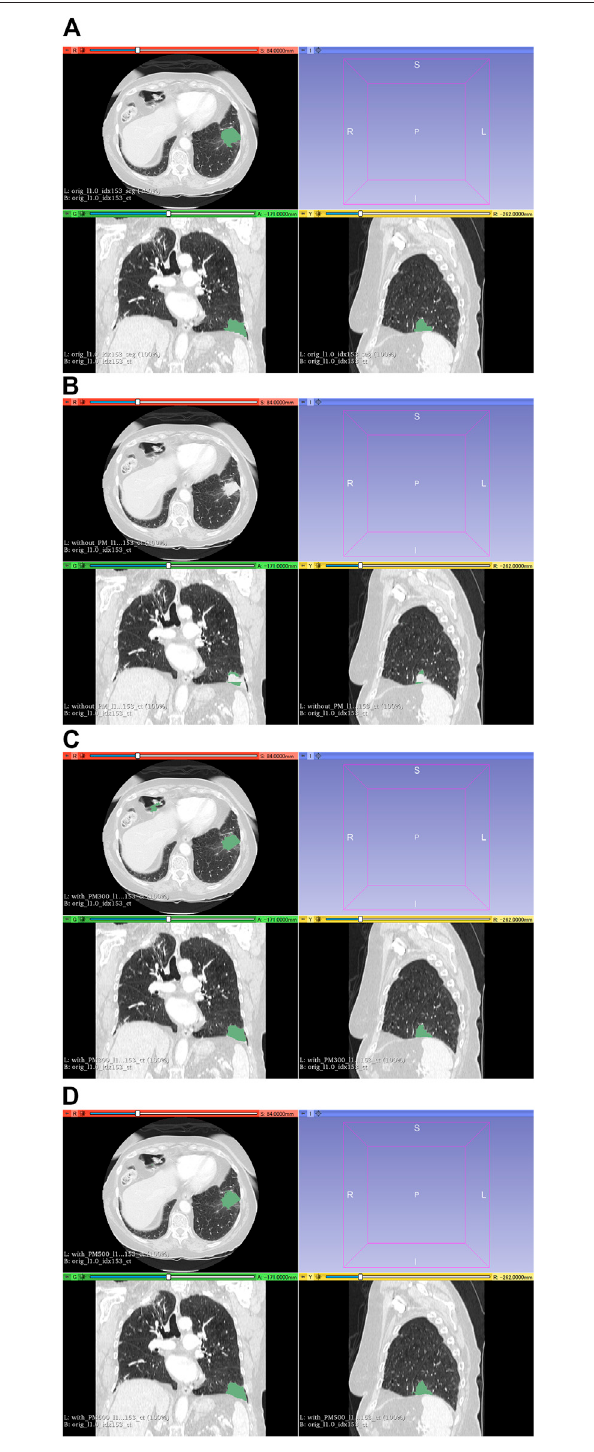
FIGURE 8 | Results of segmentation in case 104 of the test set. (A) CT images and ground-truth labels. (B) CT images and segmentation results without PM. (C) CT images and segmentation results with PM 300 . (D) CT images and segmentation results with PM 500 . Note: With the aid of PM, lung cancer is correctly segmented in (C) and (D) . Abbreviation: PM, pretrained model; PM 300 , pretrained model obtained from 300 epochs of training; PM 500 , pretrained model obtained from 500 epochs of